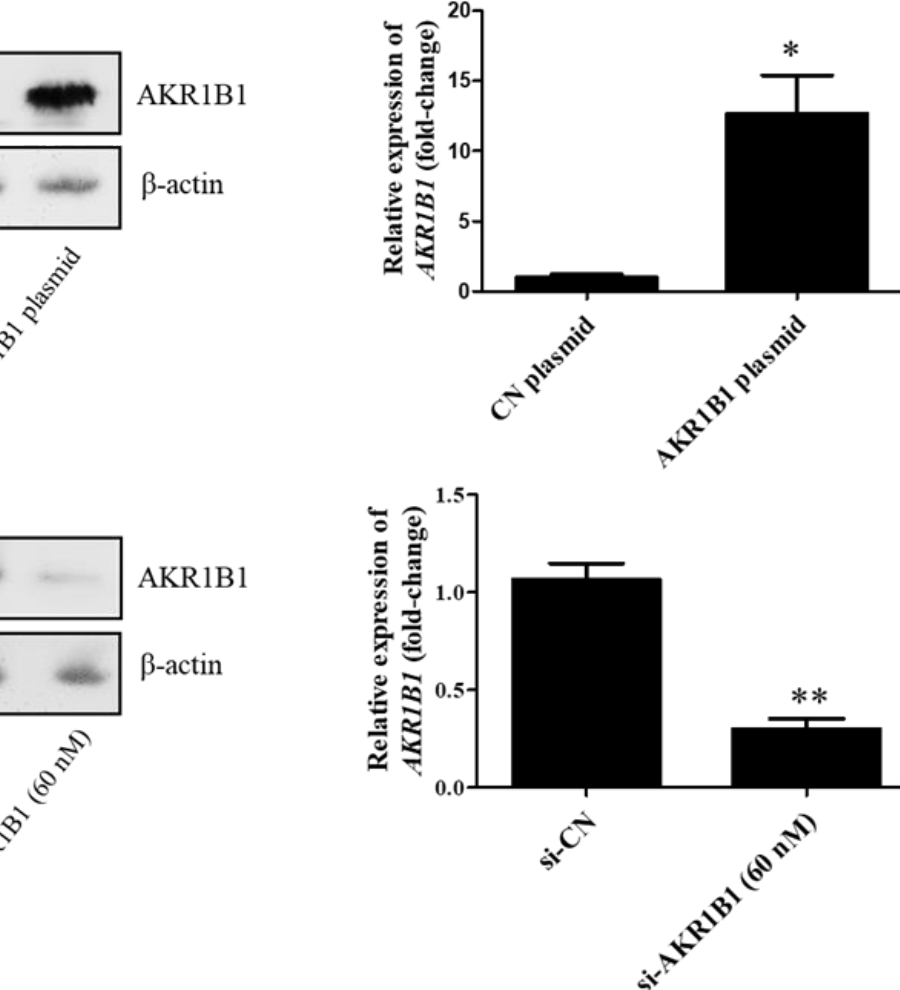
Figure 2. Transfection efficiency of the AKR1B1-expressing plasmid and AKR1B1 si-RNA. ( A ) Western blot (left panel) and quantitative reverse-transcription polymerase chain reaction (q-RT-PCR) (right panel) analysis results show increased AKR1B1 protein and mRNA levels at 24 h after transfection with the AKR1B1 plasmid in T98G cells, respectively, ( n = 3). ( B ) Western blot (left panel) and q-RT-PCR (right panel) analysis results reveal that AKR1B1 protein and mRNA levels significantly declined at 72 h after siRNA transfection in 8401 cells ( n = 3). Data are presented as mean ± SEM comparing 8401 glioma cells treated with the control plasmid (CN plasmid) or the control si-RNA (si-CN); * p < 0.05 and ** p <